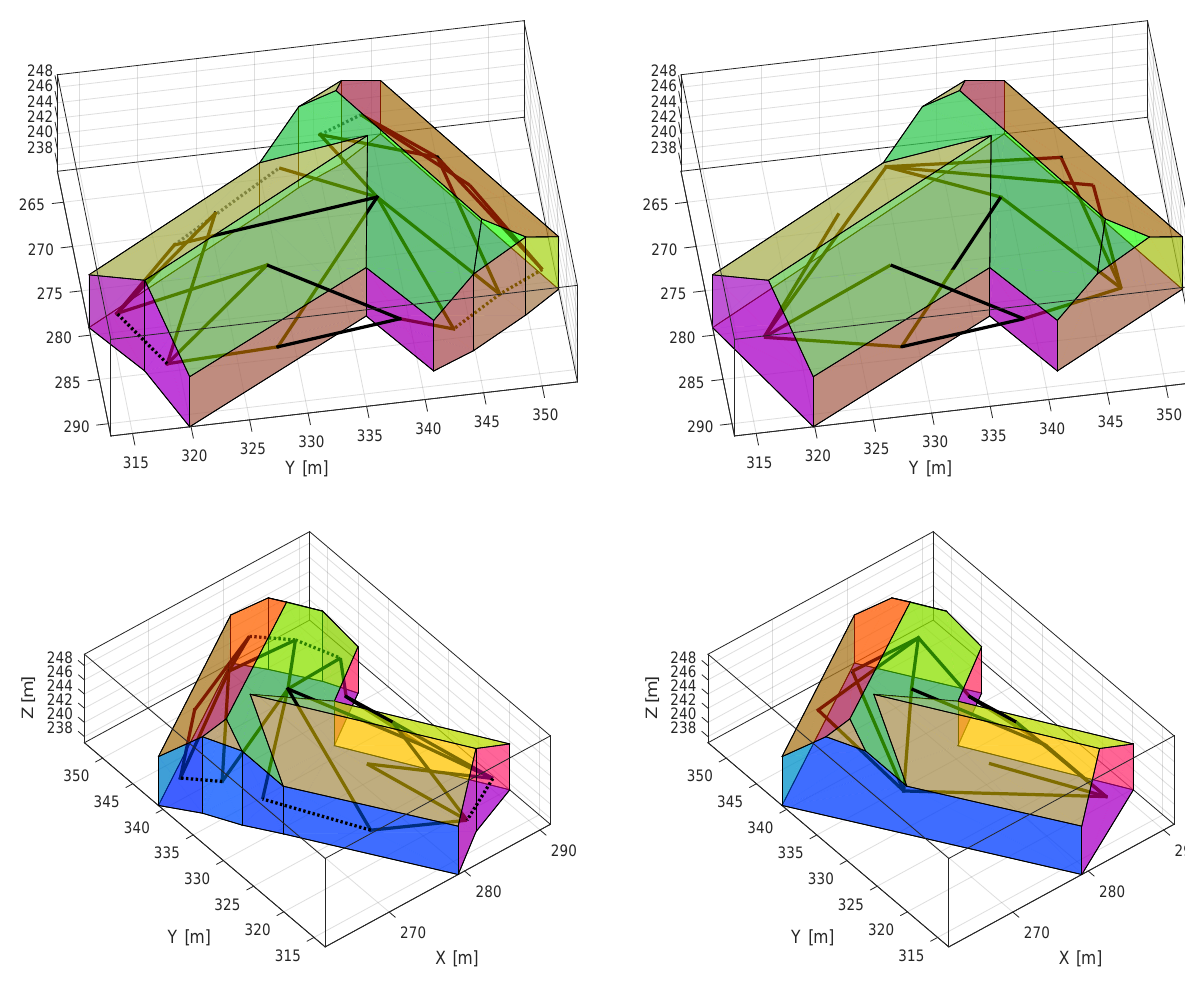
Figure 3. Derived constraints for the initial boundary representa- tion with 19 faces, depicted in two views. 28 times orthogonality ( − ) and 5 times identity ( · · · ). The numerous constraints for the floor are not depicted for the sake of clarity.